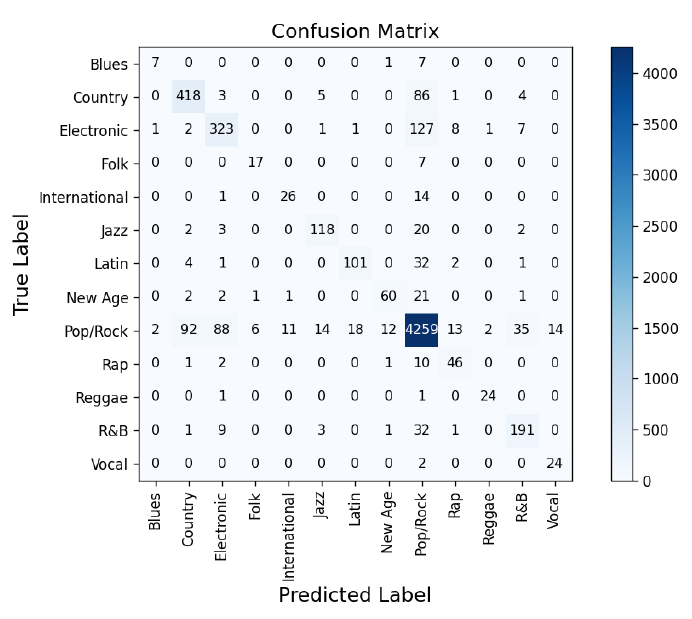
Figure 8. Confusion matrix of test result for the CNN-based classifier.